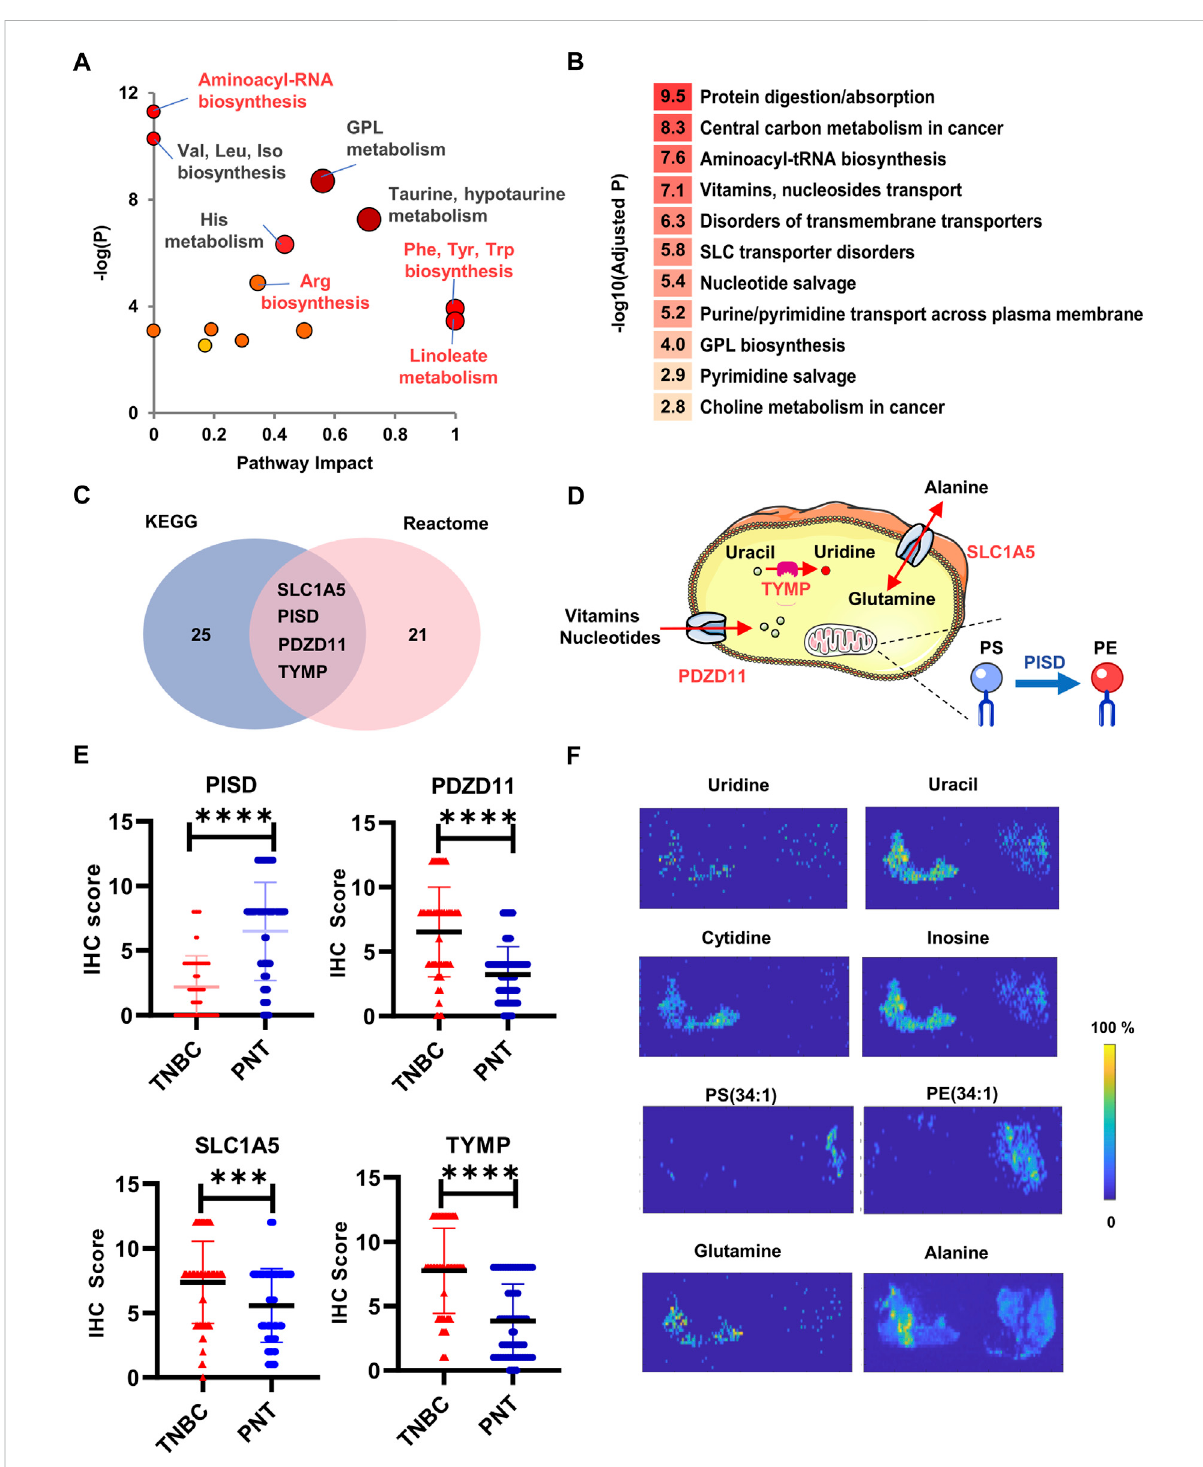
FIGURE 4 Bioinformatic analysis and expression validation for the dysregulated enzymes and transporters. (A) The enriched metabolic pathways by searching in the Metaboanalyst; (B) Rank of in fl uenced biological functions that enzymes, and transporters are involved; (C) The enriched enzymes and transporters by searching in KEGG and Reactome; (D) Diagram illustrates the subcellular locations and functions of the PDZD, PISD, TYMP, and SLC1A5; (E) Boxplotsof PISD, PDZD11, TYMP, and SLC1A5 across TNBC and PNT regions; (F) Distribution across the PNT (left) and TNBC (right) formetabolitesubstratesandproductscorrespondingtoTYMP(Uridine,Uracil),PDZD11(Cytidine,Inosine),PISD(PS(34:1)andPE(34:1)),andSLC1A5 (Glutamine, Alanine). **** p <